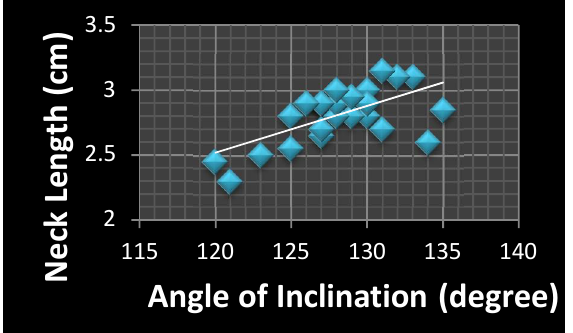
Table 1: Showing the result of Femoral Angle of Inclination and Neck length.